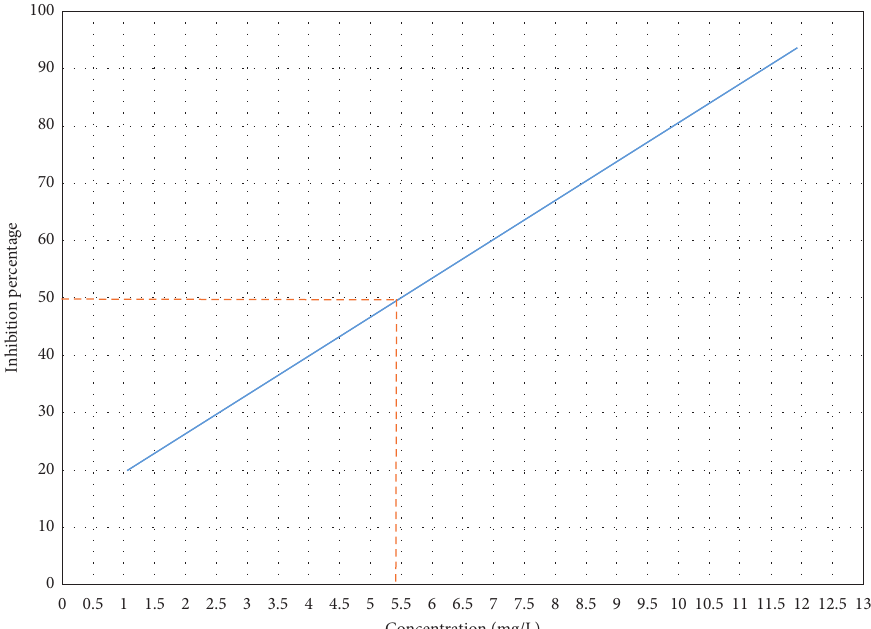
Figure 3: Plot of inhibition percentage with respect to concentration (mg/L) of triplicated measurements in two separate sample runs of Cinnamomum zeylanicum ice